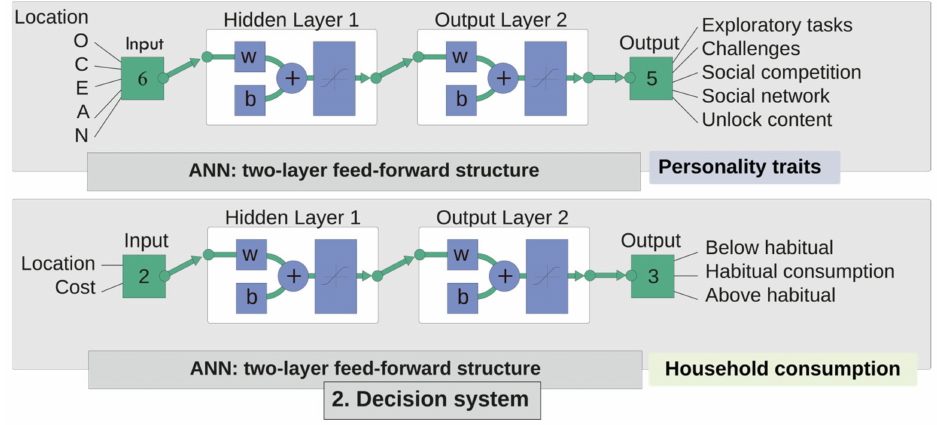
Figure 5. Decision system proposed in this